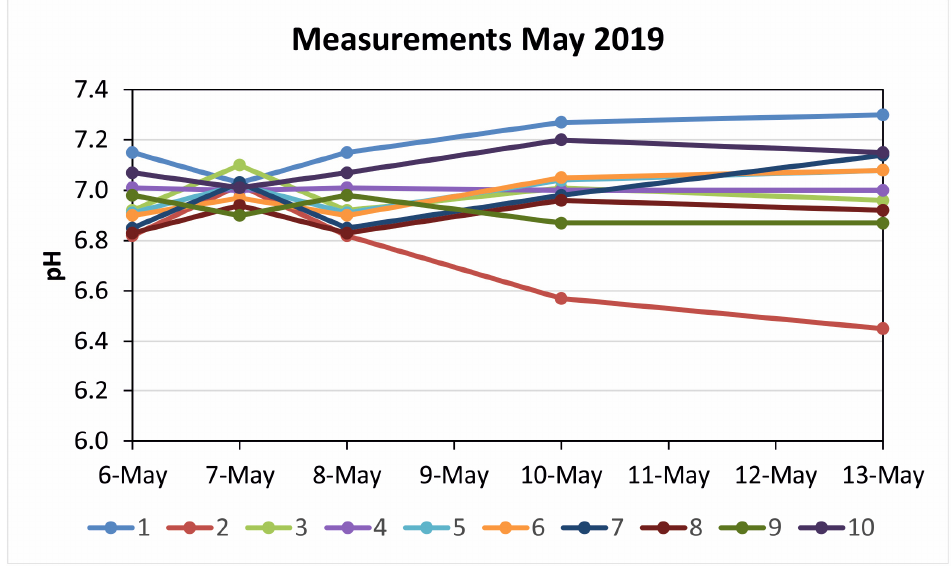
Figure 5. pH average results obtained during the evaluation carried out on May 2019. Numbers at the bottom of the X axis are the sensor numbers.